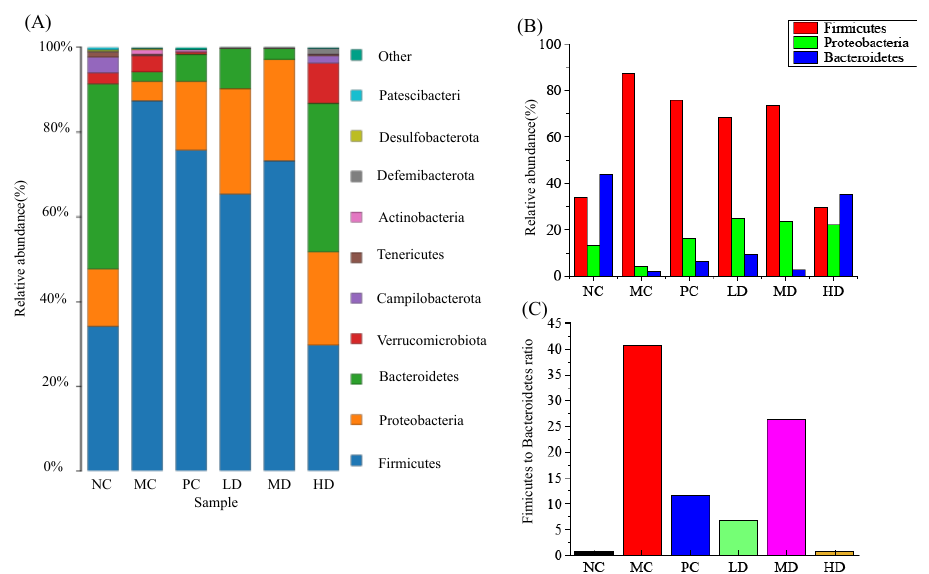
Figure 7. Effects of RFV on the gut microbiota. ( A ) Relative abundance of gut microbiota at the phylum level; ( B ) Relative abundance of Firmicutes , Bacteroidetes and Proteobacteria ; ( C ) Firmicutes to Bacteroidetes ratio. Each phylum is represented by a unique color. NC: normal group (normal feed, 0.9% saline); MC: model group (HFD, 0.9% saline); PC: positive group (HFD, 0.5 mg/mL xuezhikang capsules); LD: RFV low dose group (HFD, 10% RFV); MD: RFV medium dose group (HFD, 30% of RFV); HD: RFV high dose group (HFD, 50% of RFV).